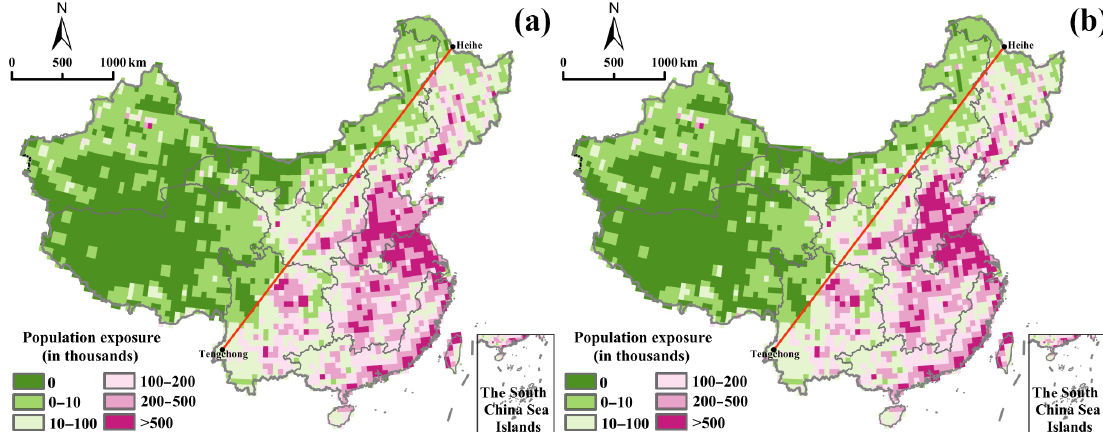
Figure 2. Spatial distribution of population exposure to droughts in (a) the reference period (1986–2005) and (b) the 1.5 ◦ C global warming scenario (2020–2039 in RCP2.6). (Red line is the Hu line, an imaginary line that diagonally divides the area of China into two parts, stretching from the city of Heihe in Heilongjiang Province to Tengchong in Yunnan Province, which is also called the “geo-demographic demarcation line”.) Please note that the above figure contains disputed territories.